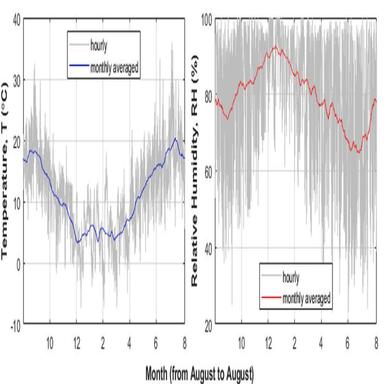
Simulated Climate with Temperature and Relative Humidity profiles plotted against Months.